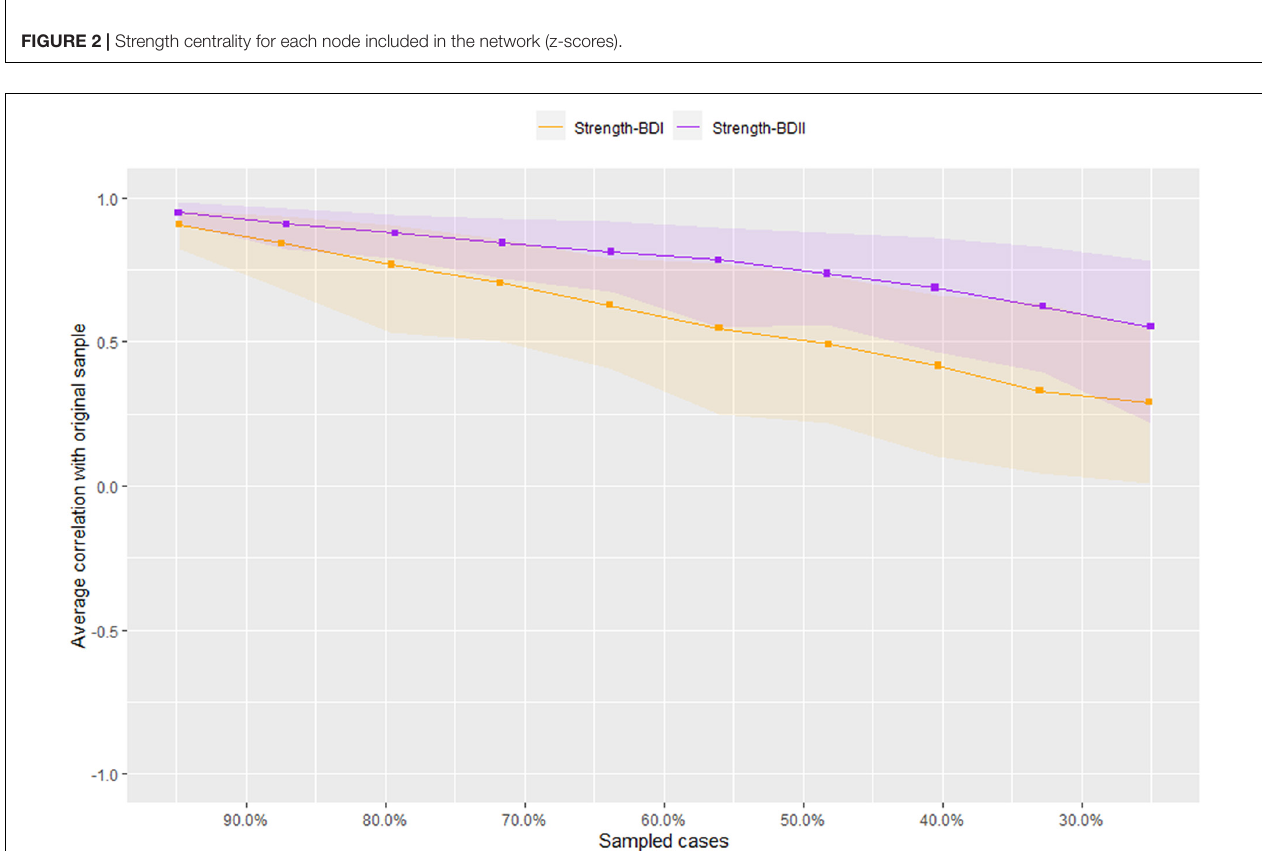
FIGURE 3 | Stability of network structures in patients with bipolar I/II disorders. The x-axis represents the included percentage of study samples, and the y-axis indicates the correlations between the original centrality index (i.e., strength) and the estimated one after dropping different proportion of study samples. Different color lines indicate different network properties (CS-C BD - I = 0.126, CS-C BD - II =